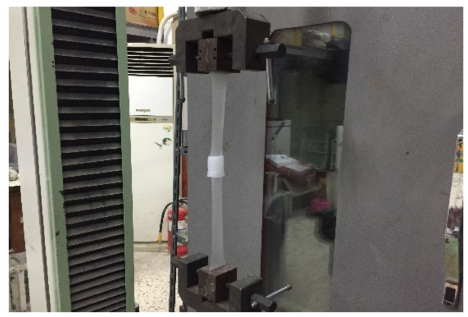
Figure 5. Joint tensile performance test